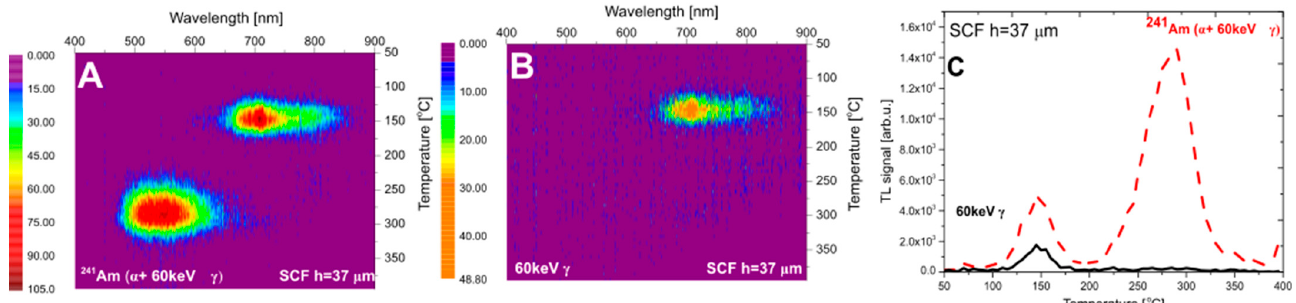
Figure 6. The emission spectra of LuAG: Ce SCF/YAG SC (h SCF = 37 μ m) (#2) after irradiation with 241 Am ( panel A —irradiation with bare source ( α + 60 keV γ ), panel B —irradiation with covered source (only 60 keV γ ), panel C —TL glow curves taken from the spectral measurements (integration in range 400–700 nm)).